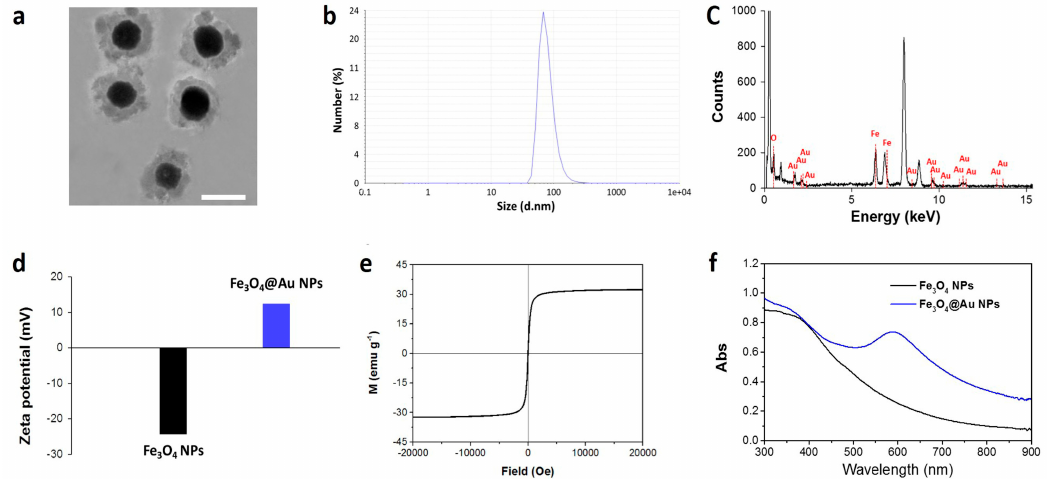
Figure 1. Characterization of Fe 3 O 4 @Au nanoparticles (NPs). ( a ) TEM images (scale bar: 100 nm); ( b ) Dynamic light scattering analysis of Fe 3 O 4 @Au NPs; ( c ) Energy dispersive X-ray spectrum of Fe 3 O 4 NPs; ( d ) Zeta potential of Fe 3 O 4 NPs and Fe 3 O 4 @Au NPs; ( e ) Magnetization curve of Fe 3 O 4 @Au NPs at 300 K; ( f ) UV-visible-near infrared (NIR) extinction spectrum of Fe 3 O 4 NPs and Fe 3 O 4 @Au NPs.